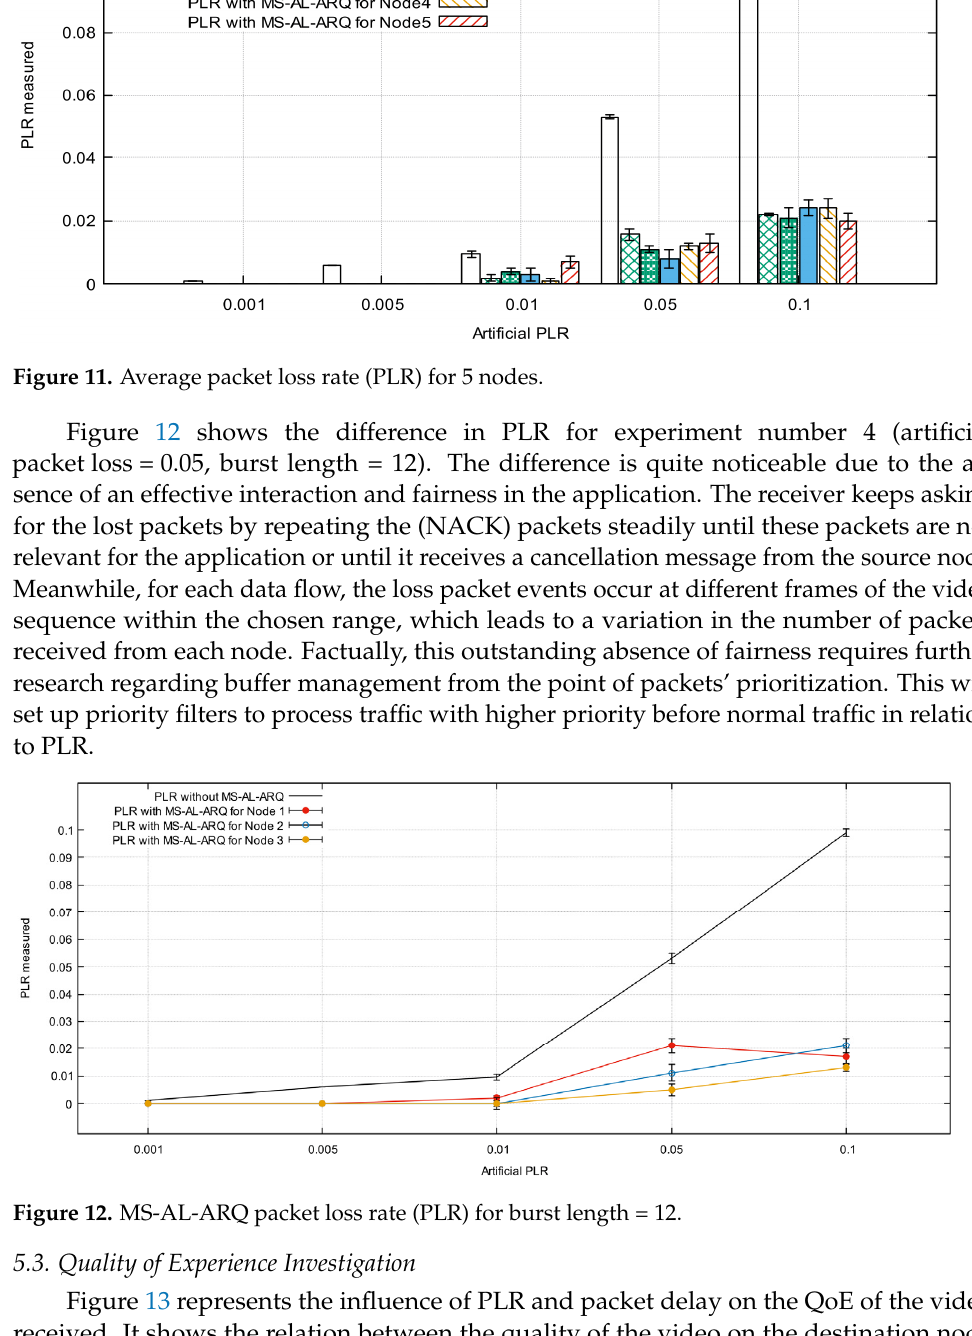
Figure 10. Average packet loss rate (PLR) for 3 nodes.